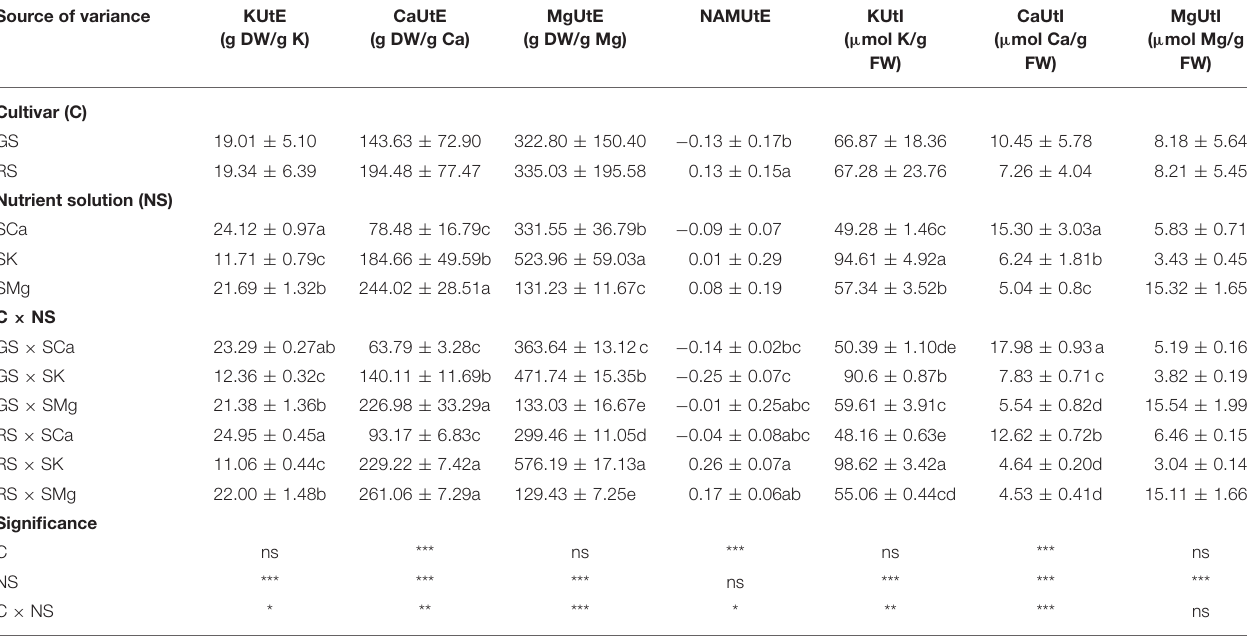
TABLE 1 | Effects of the cultivar (C) and of the nutrient solution (NS) on the utilization of K, Mg, and Ca in leaves. Source of